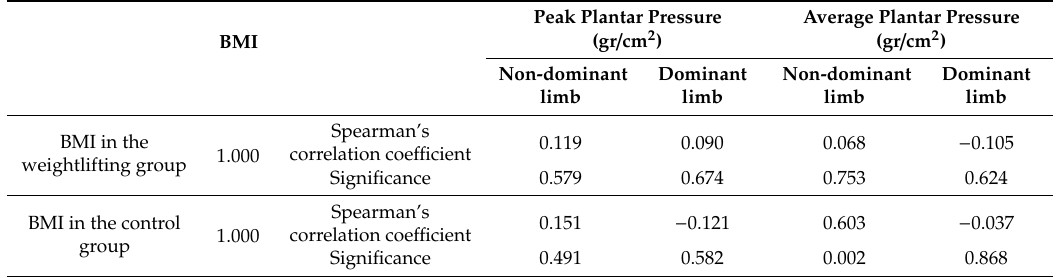
Table 7. Spearman’s rank correlation coe ffi cients of BMI and dynamic peak and average plantar pressure of the dominant and non-dominant limb in both